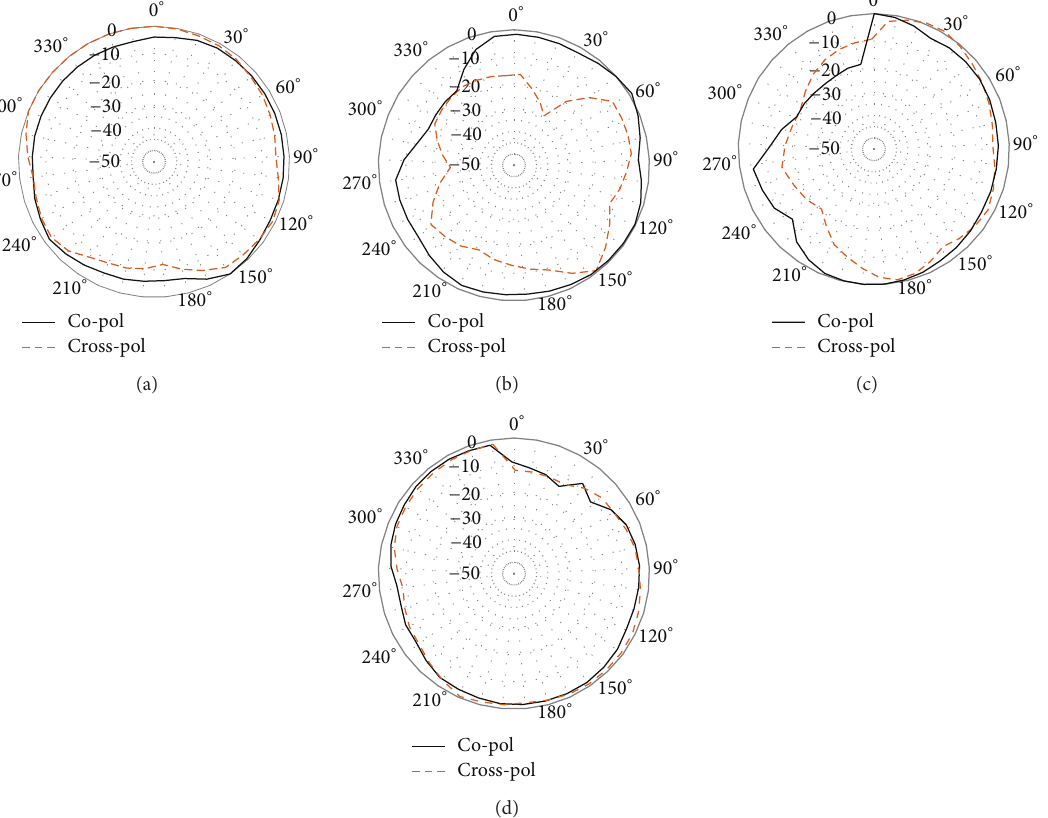
Figure 14: Normalized radiation pattern of the resonator at (a) 5.5 GHz ( 𝐸 -plane), (b) 8.3 GHz ( 𝐸 -plane), (c) 5.5 GHz ( 𝐻 -plane), and (d) 8.3 GHz ( 𝐻